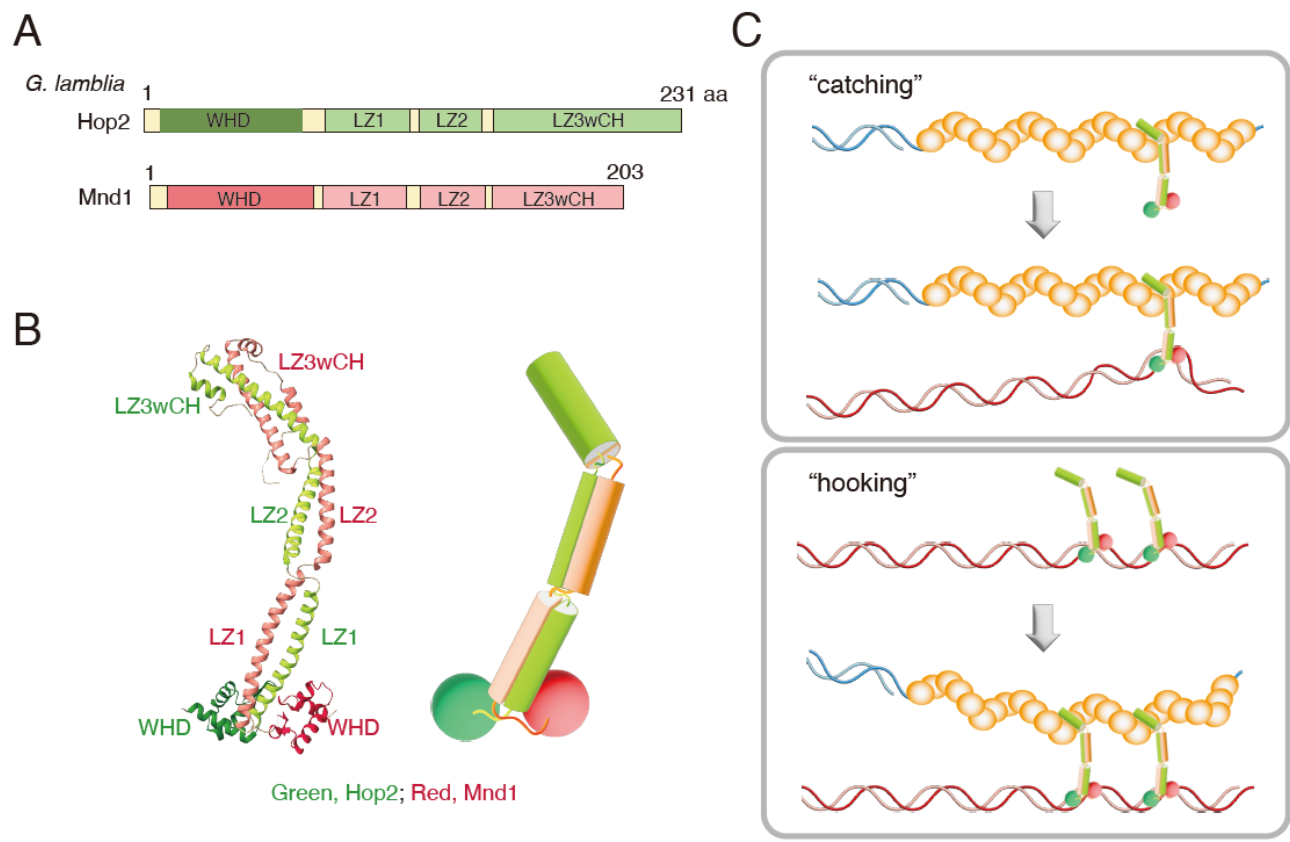
Figure 4. ( A ) Domain organizations of G. lamblia Hop2 and Mnd1. WHD, winged-helix domain; LZ, leucine zipper; LZwCH, leucine zipper with capping helices. ( B ) Left , crystal structure of the G. lamblia Hop2-Mnd1 complex (4Y66, chains D and C). Right , schematic drawing of the Hop2-Mnd1 complex. ( C ) Two models of the function of Hop2-Mnd1 in homologous recombination. See the main text for details.